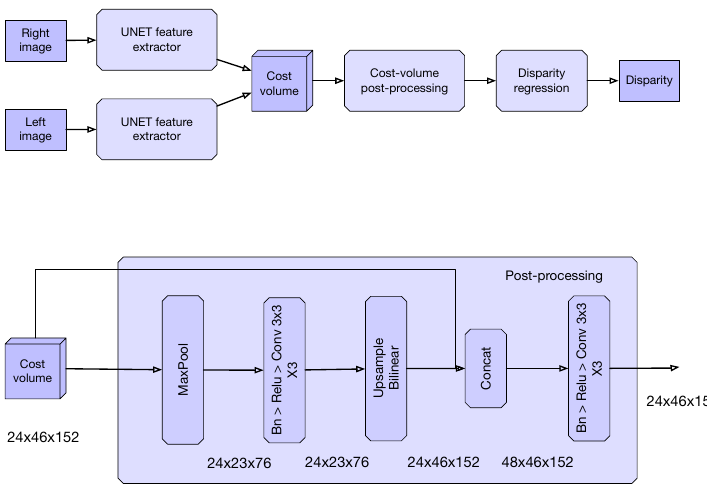
Figure 2. Final model. ( top ) First proposal, a single step stereo depth estimation model. ( bottom ) Second proposal, a cost volume postprocessing method using 2D convolutions instead of a sequence of 3D convolution